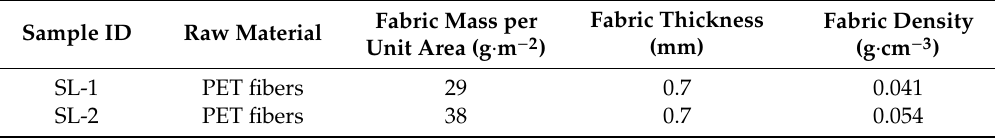
Table 1. Structural characteristics of tested non-woven fabric.